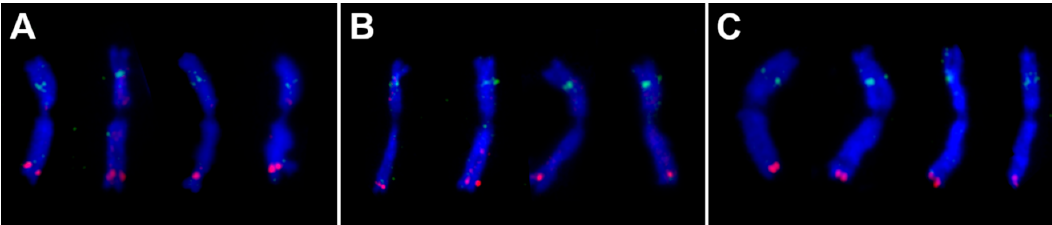
Figure 1. FISH on metaphase 7D chromosomes of bread wheat cv. Chinese Spring with probes for GAA microsatellite (green) and three tandem repeats (red). ( A ) TaeCsTr163, ( B ) TaeCsTr230 and ( C ) TaeCsTr99 repeats localized in subtelomeric region of the 7DS chromosome arm. 7D chromosomes were identified based on the GAA hybridization signal on the 7DL arm. The chromosomes were counterstained by DAPI (blue).